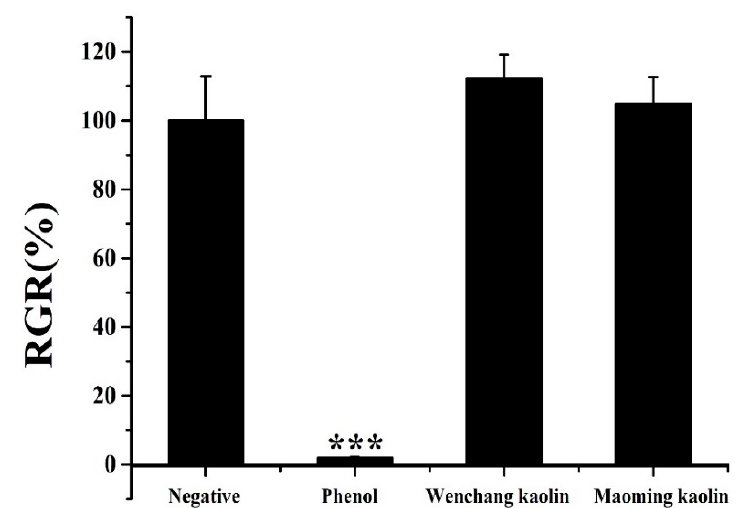
Figure 9. Biocompatibility of kaolin samples using MTT assay (n = 3). (*** indicates extraordinary difference with untreated control and p < 0.001).